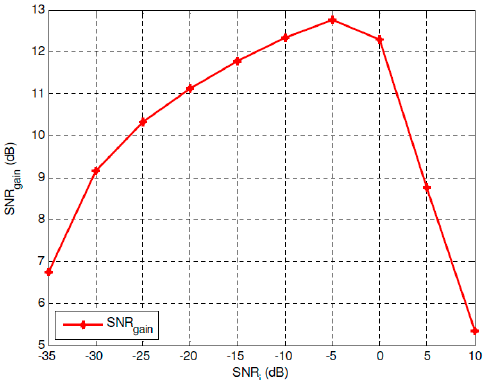
Figure 7. SNR improvement by using the proposed optimal SR approach.